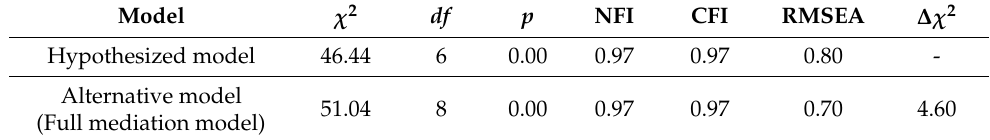
Table 4. Model fitness index for the hypothesized model and the alternative model.